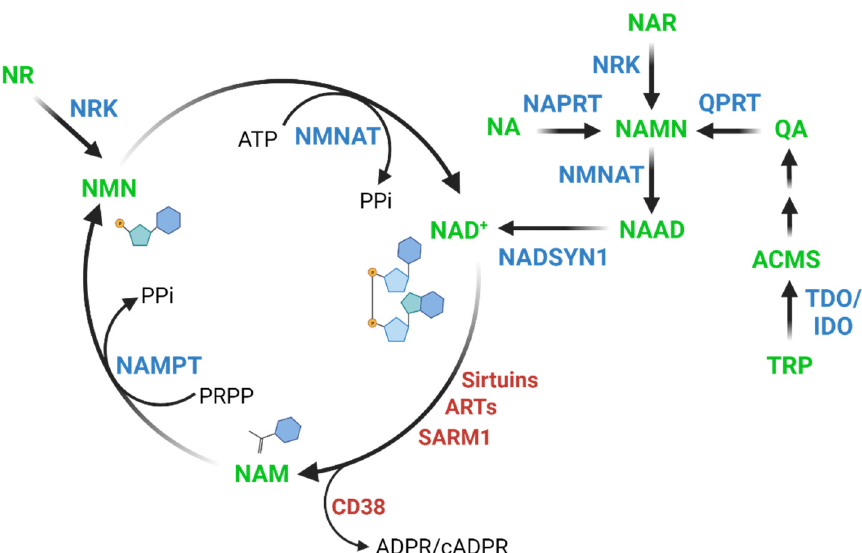
Figure 1. NAD + biosynthesis pathways in mammalian cells. ACMS: 2-amino-3-carboxymuconate, NA: nicotinic acid, NAD + : nicotinamide adenine dinucleotide, NAM: nicotinamide, NAMN: nicotinic acid mononucleotide, NAR: nicotinic acid riboside, NMN: nicotinamide mononucleotide, NAAD: nicotinic acid adenine dinucleotide, NR: nicotinamide riboside, QA: quinolinic acid, TRP: